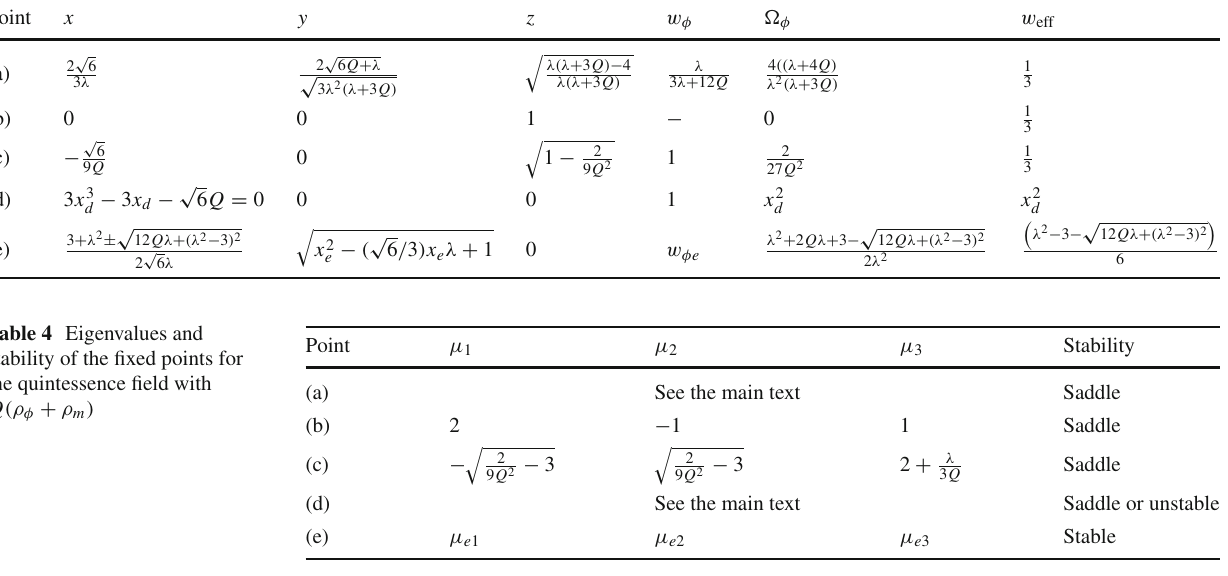
Table 3 Critical points ( x , y and z ) of Eqs. (24)–(26) for the quintessence field with interaction Q (ρ φ + ρ m ) . The table shows the correspondent equation of state for the dark energy (15), the effective equation of state (16) and the density parameter for dark energy (12) Point